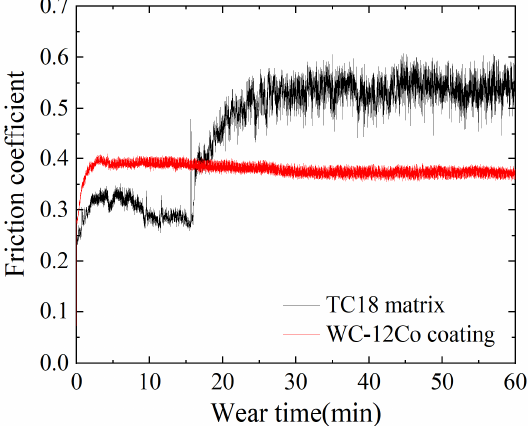
Figure 15. The friction coefficients of the TC18 substrate and the WC-12Co coating.